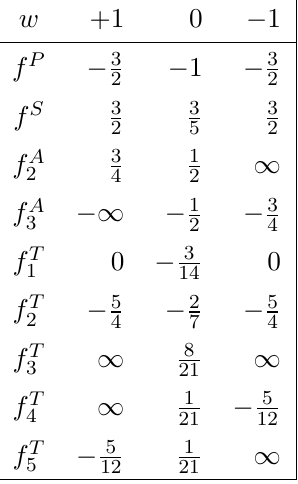
A ( q 2 ; q 2 ) is assumed to vanish, which, apart from the overall 2 1 2 F